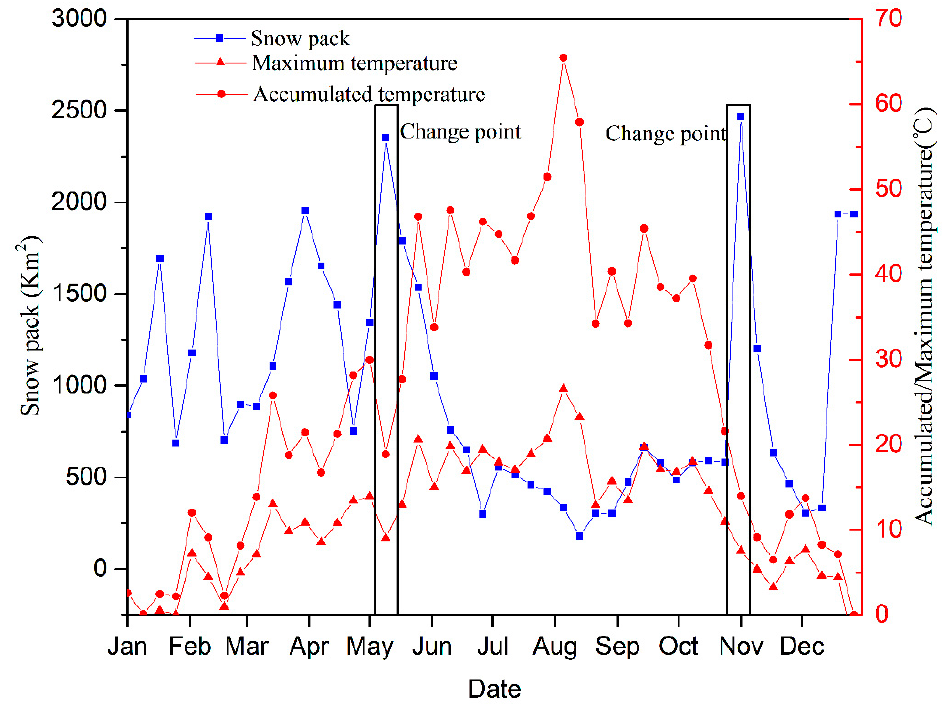
Figure 3. Relationship between temperature and snow cover in 2013.